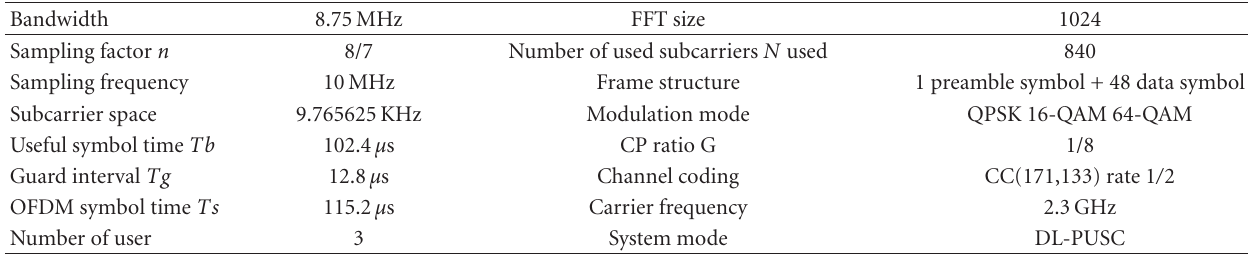
Table 1: Profile parameters.